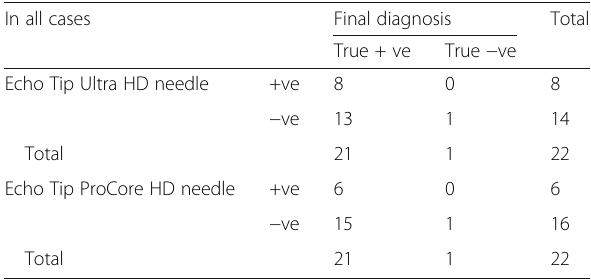
Table 1 Sensitivity, specificity, predictive value, and diagnostic accuracy of both needles in the study population In all cases